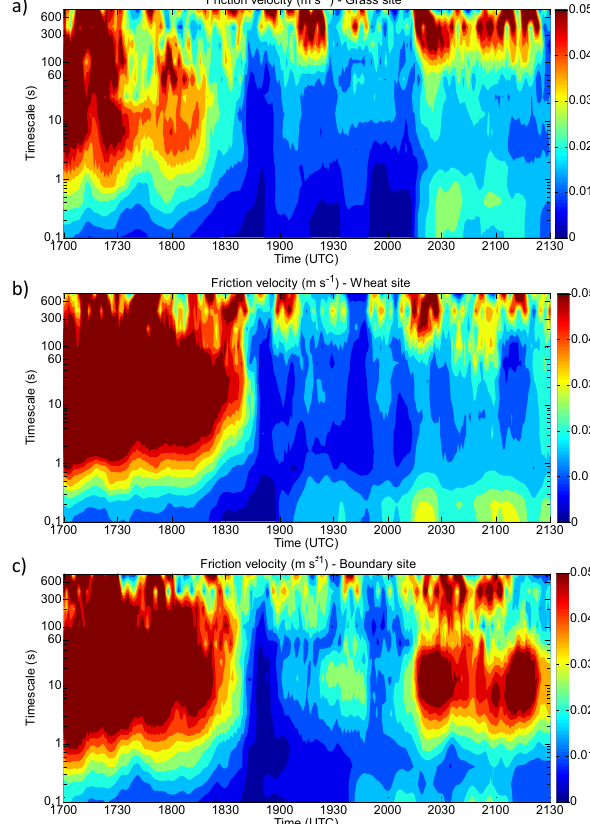
Figure 10. Multi-resolution flux decomposition (MRFD) of kine- matic heat flux (Kms − 1 ) at 0.8ma.g.l. (a) , 2ma.g.l. (b) and 8ma.g.l. (c) at the divergence site.